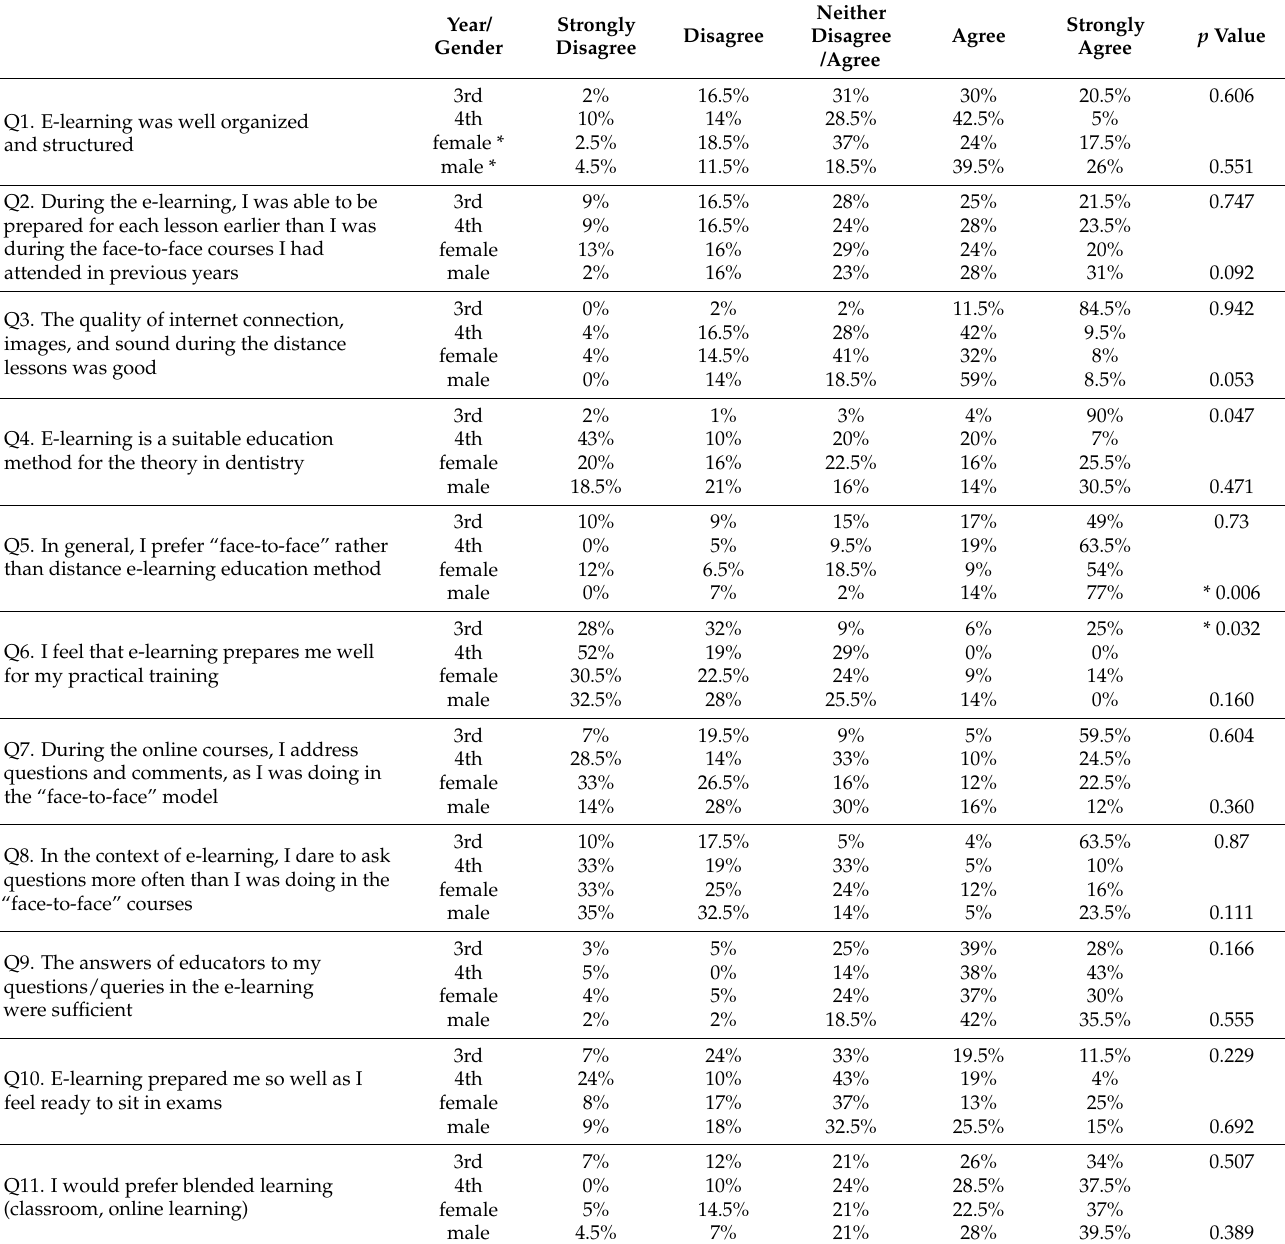
Table 2. Results for the questions concerning distance e-learning education of third- and fourth-year students in school A (dental School of Athens). Neither Year/ Strongly Strongly p Disagree Disagree Agree Gender Disagree Agree /Agree